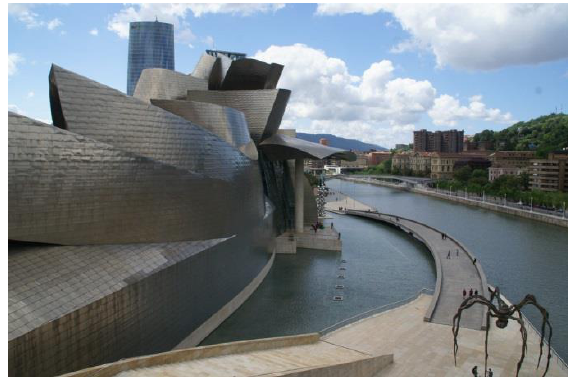
Fig. 31 Chapelle Notre dame du Haut (Ronchamp,1950)